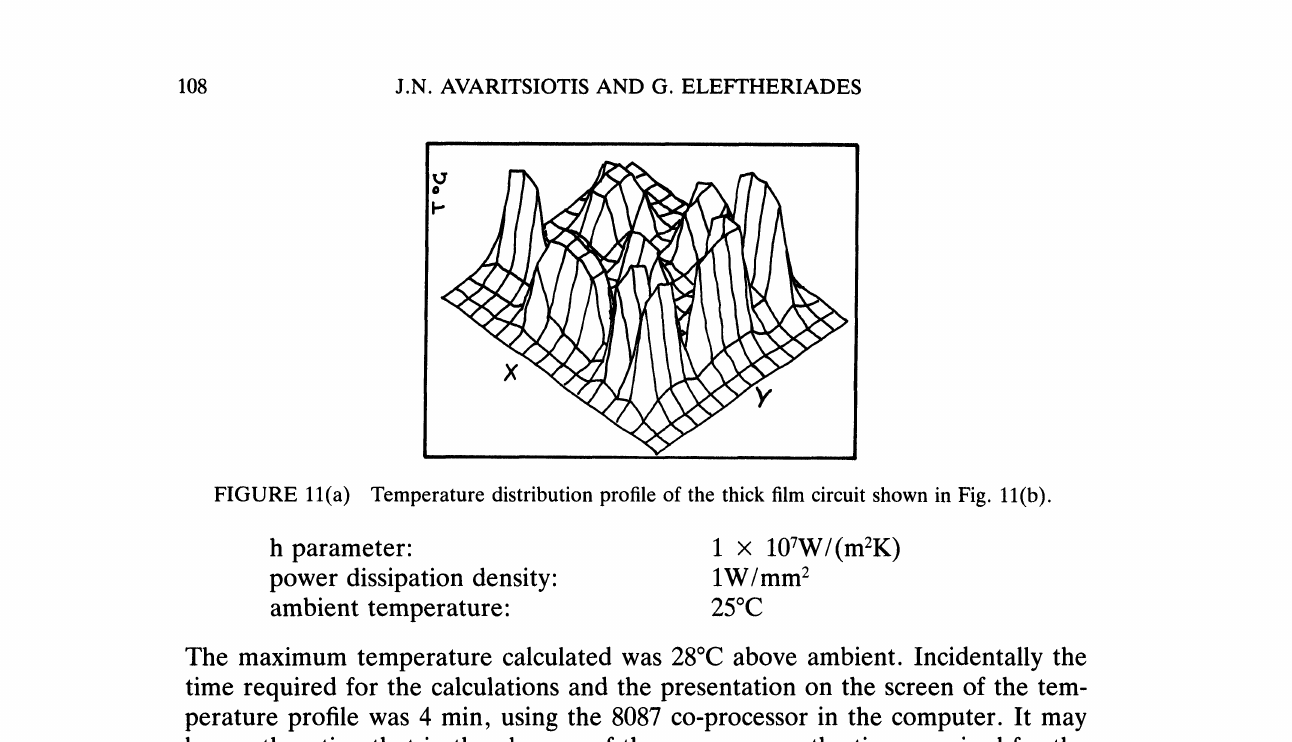
FIGURE ll(a) Temperature distribution profile of the thick film circuit shown in Fig.